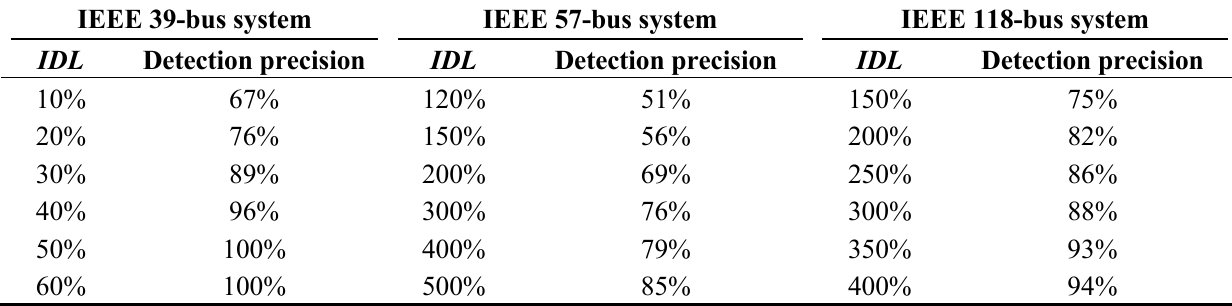
Table 2. Detection precision of the Chi-squares test against TFDI